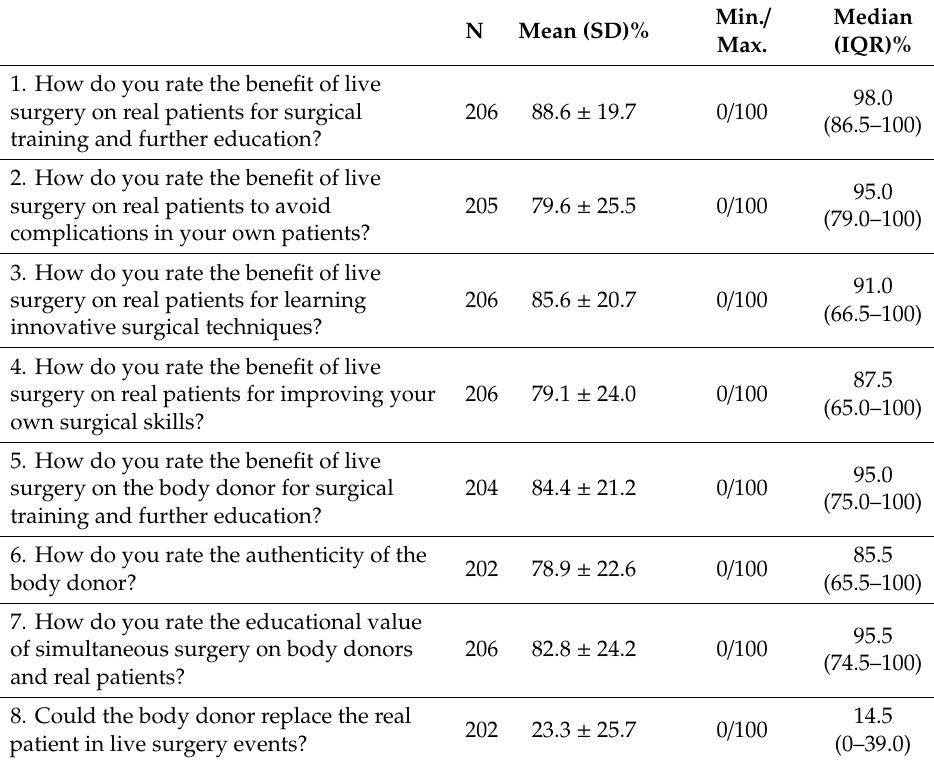
Table 1. Questionnaire: items and